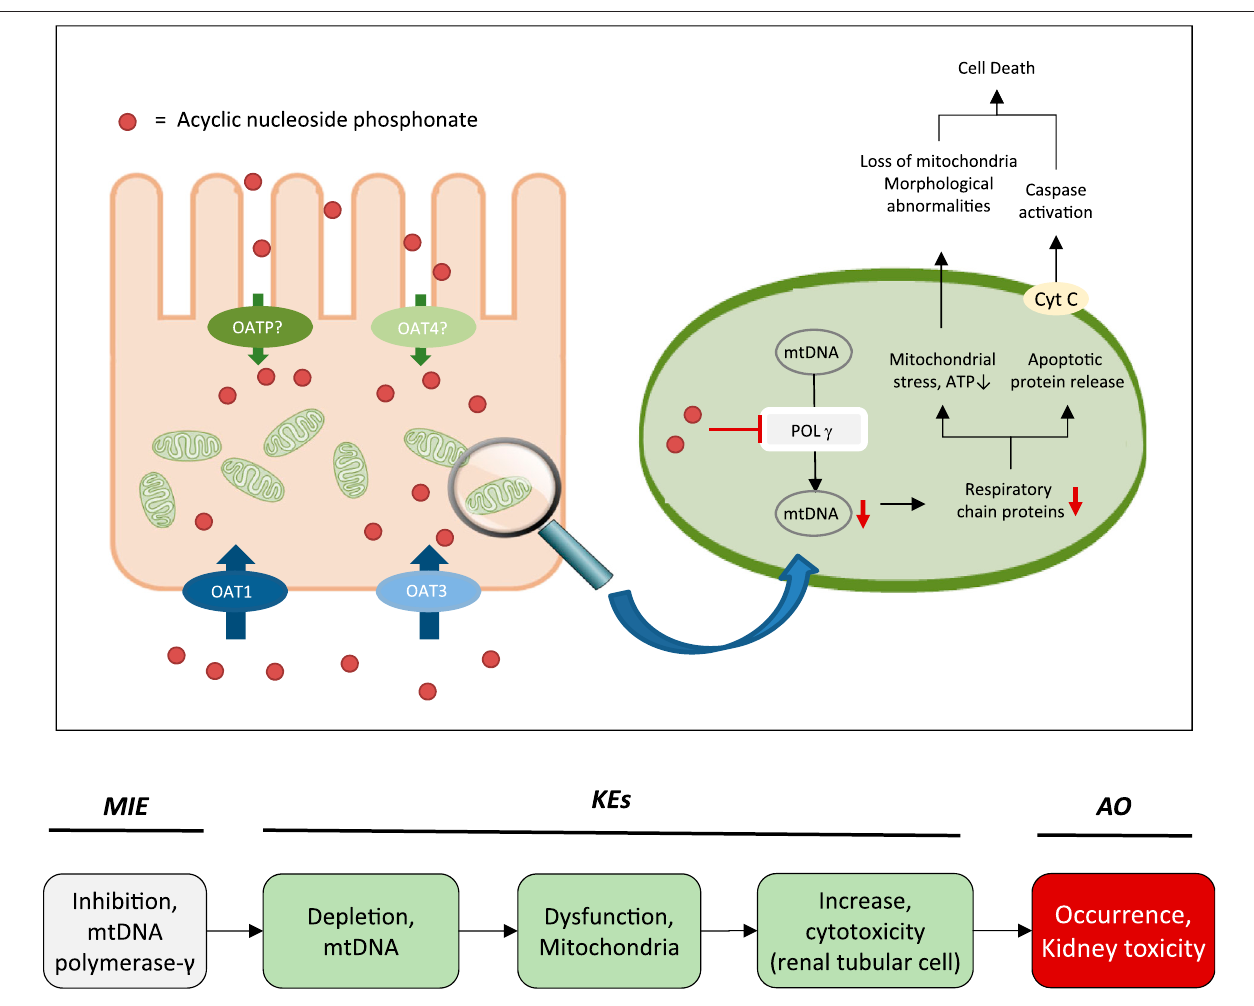
FIGURE 2 | Active transport of acyclic nucleoside phosphonates into proximal tubule cells predominantly via basolateral in fl ux carriers (OATs and OAT3) and subsequent disruption of proximal tubular mitochondrial function due to inhibition of mitochondrial DNA Pol γ (modi fi ed from (Fernandez-Fernandez et al., 2011)). Adverse outcome pathway of inhibition of mitochondrial DNA Pol γ leading to kidney